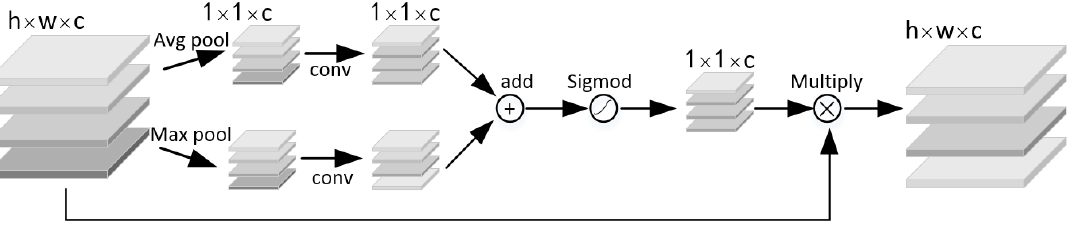
Figure 4. Schematic of the channel attention module.